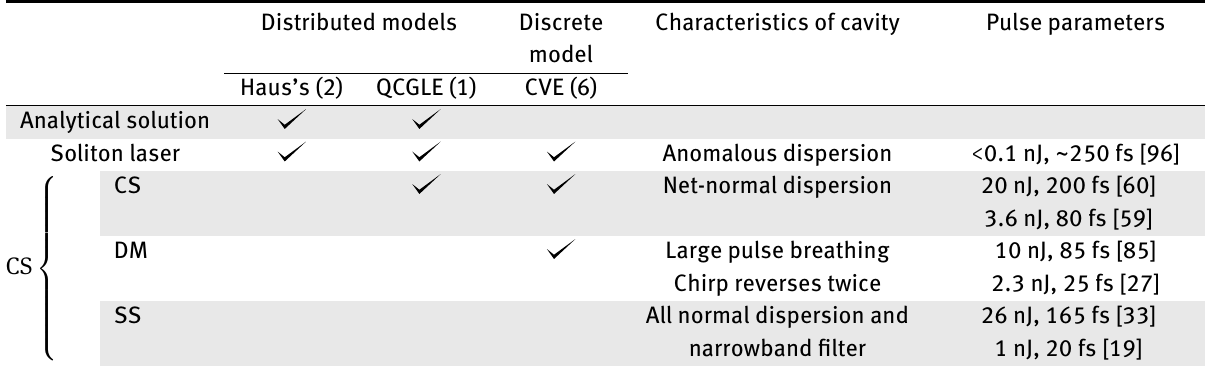
Table 1: Comparison of different theoretical models and fiber lasers.